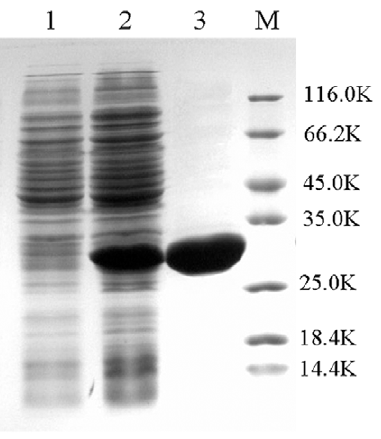
Figure 7. Overexpression of the dmtH gene in E.coli and target protein DmtH purification. The DmtH protein was separated on an SDS-polyacrylamide gel. E. coli Rosetta 2(DE3) harboring pET28a was used as the control (lane 1). E. coli Rosetta 2(DE3) harboring pET dmt was incubated with 28 KDa DmtH protein (lane 2). DmtH protein was incubated after purification (lane 3). Protein markers are on the right.